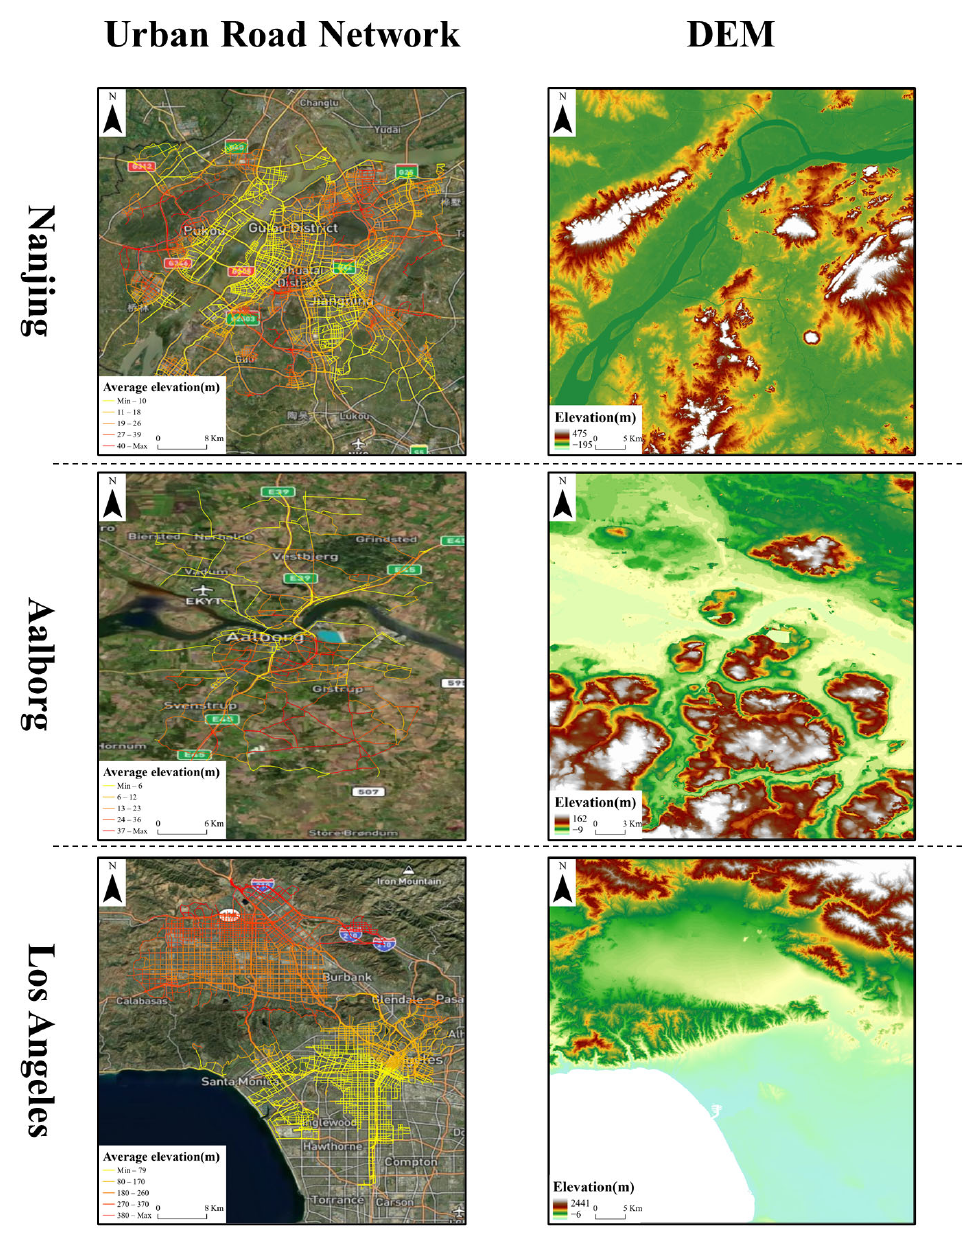
Figure 9. The average elevation of edges and DEM in three different areas. Figure 10 shows the distribution of absolute grade differences between the uncor ‐ rected network and the correct network in Nanjing. The red line in the legend indicates that the absolute grades of edges are greater than 0.07, the maximum of grades in the road construction standards, whilst the blue line is the opposite. The result shows that the ma ‐ jority of edges with excessive absolute grades are corrected to less than 0.07.